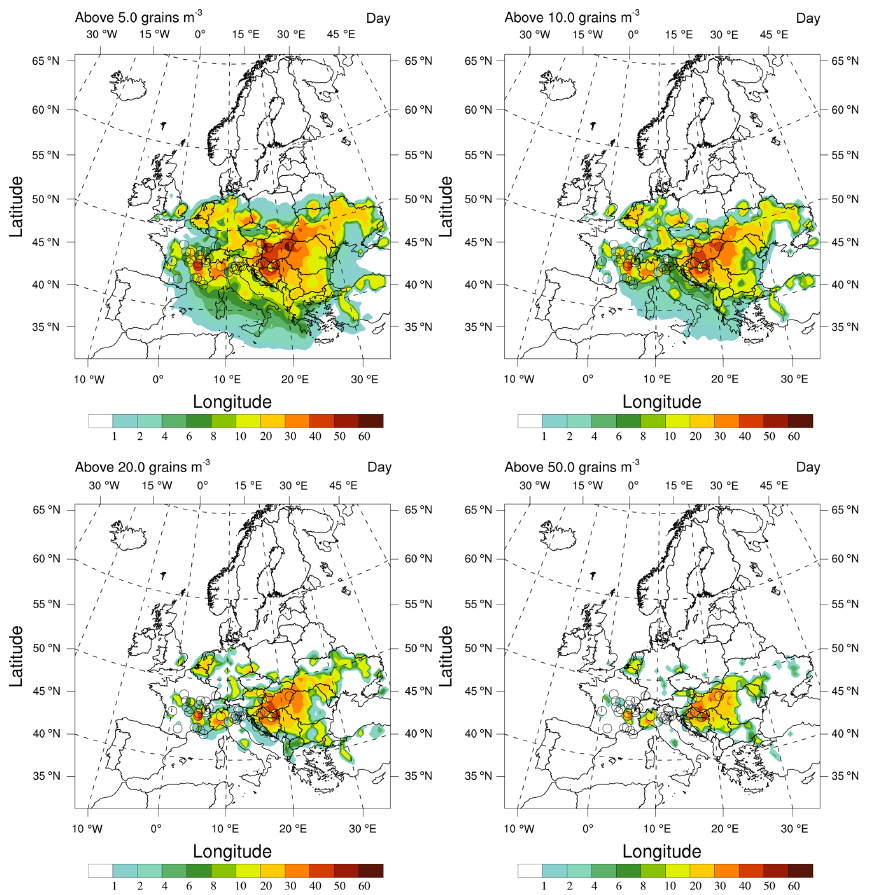
Figure 11. Number of days when the daily average concentration exceeding certain risk levels. Ground-based measurement locations are indicated with circles coloured by the measured number of days (left half) and corresponding simulated number of days (right